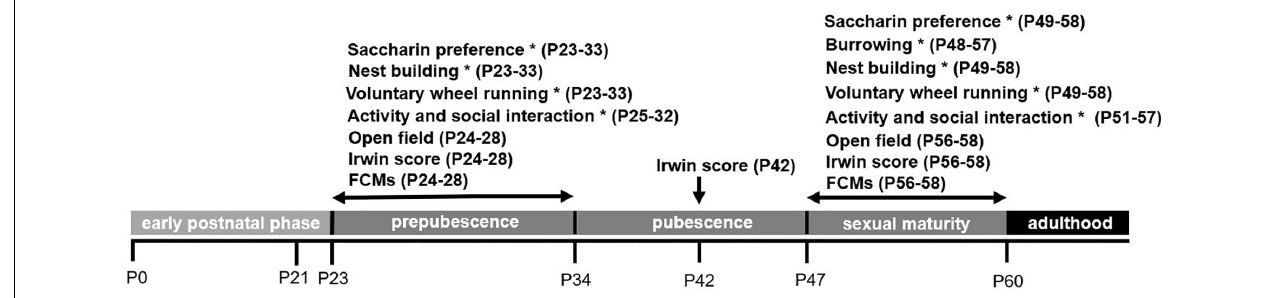
FIGURE 1 | Overview of the experimental scheme. FCMs refers to fecal corticosterone metabolites, * refers to behavioral tests conducted in the animals’ home cages. Age ranges of test conduction [postnatal days (P)] are provided in the